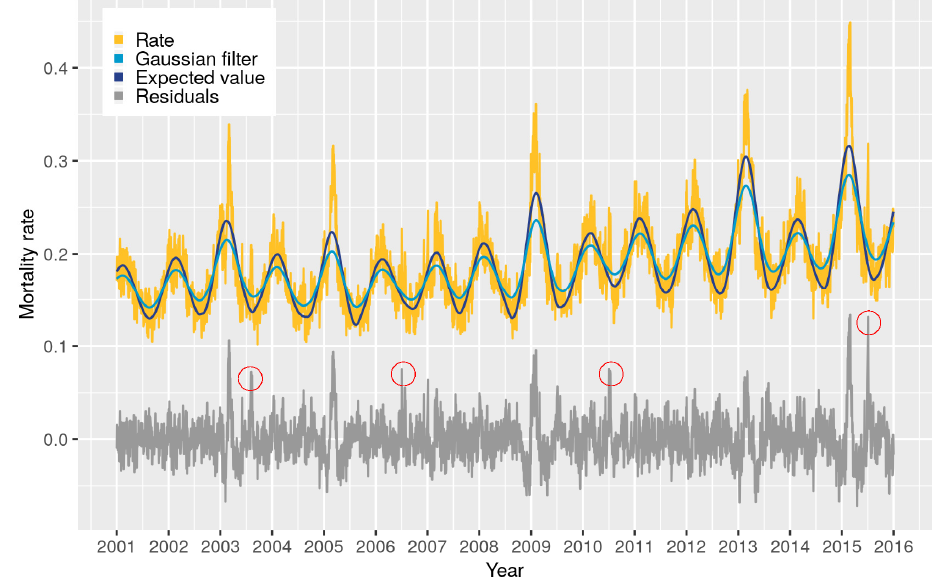
Figure 2. Expected value of CLRD mortality with population-based two-day rate (yellow), result of the Gaussian low-pass filter (light blue), the corrected filter function of expected value (dark blue) and the residuals (grey). Marked in red are the deviations of mortality during the summers 2003, 2006, 2010 and 2015.